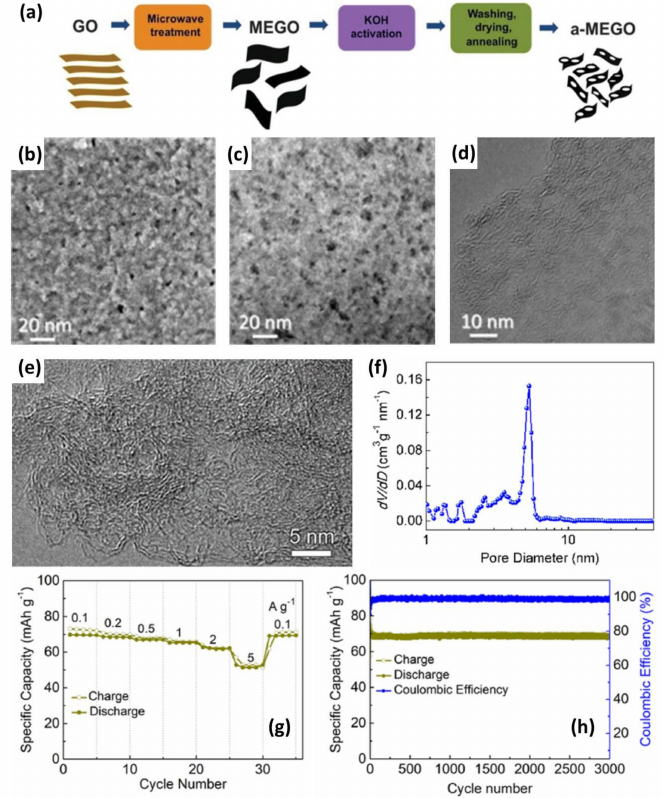
Figure 5. ( a ) Schematic of preparation of a-MEGO. ( b ) High-resolution SEM, ( c ) annular dark field STEM and ( d ) high-resolution TEM images of a-MEGO. (Reprinted with permission from Ref. [100]. Copyright 2011 American Association for the Advancement of Science.) ( e ) High-resolution TEM images and ( f ) pore size distribution curve of PG; ( g ) Rate capability and ( h ) cycling stability of PG. (Reprinted with permission from Ref. [103]. Copyright 2020